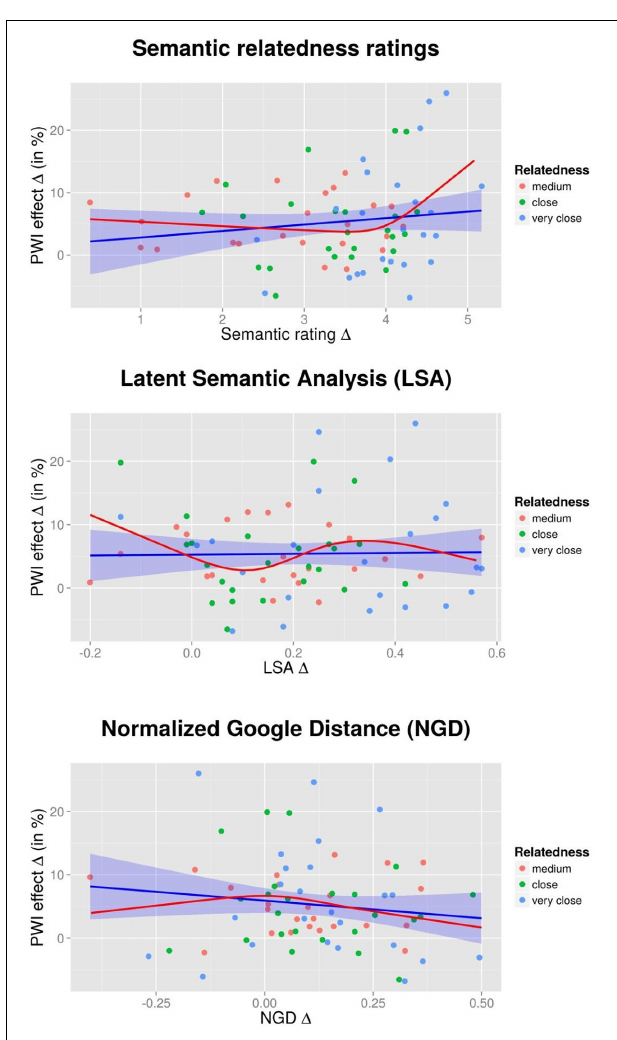
FIGURE 2 | Experiment 1—Degree of semantic interference (in percent), dependent on semantic relatedness ratings (top panel), Latent Semantic Analysis scores (LSA; middle panel), and Normalized Google Distance scores (NGD; bottom panel). Dots represent individual target-distractor combinations. The blue line corresponds to a regression between the two variables with linear terms; the red line corresponds to an analysis using restricted cubic splines (see text for